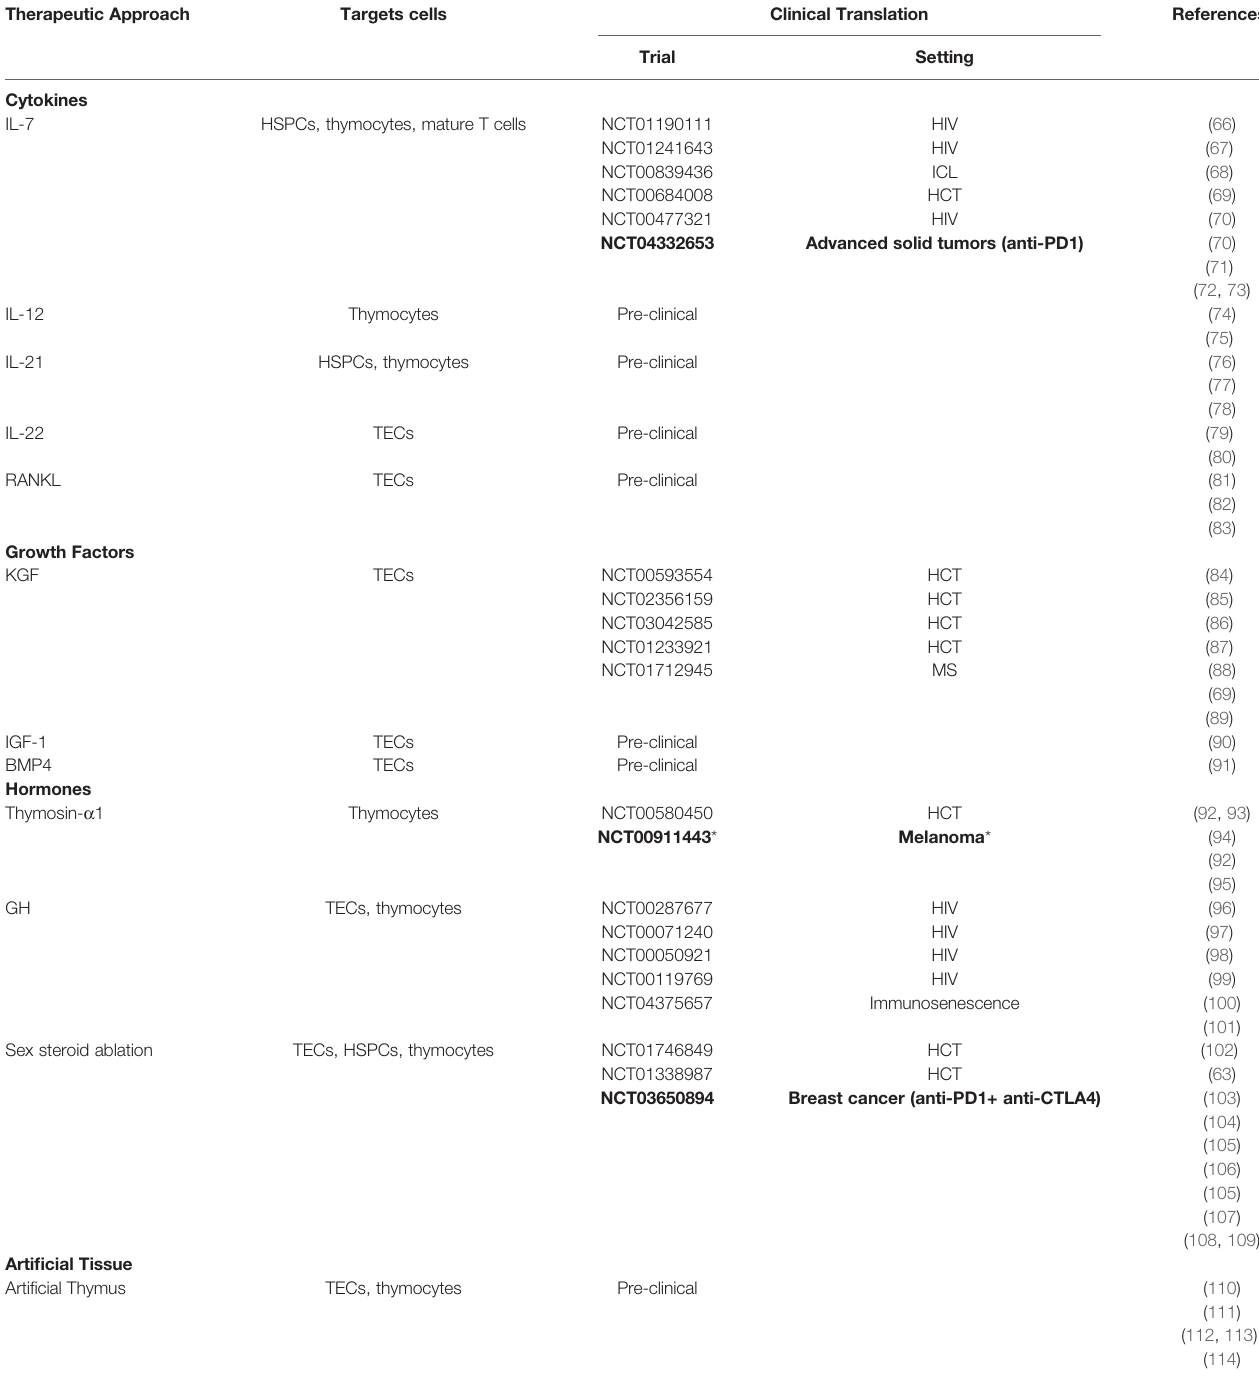
TABLE 1 | Approaches, discussed in the review, to promote thymic function, their targets and their evaluation in clinical